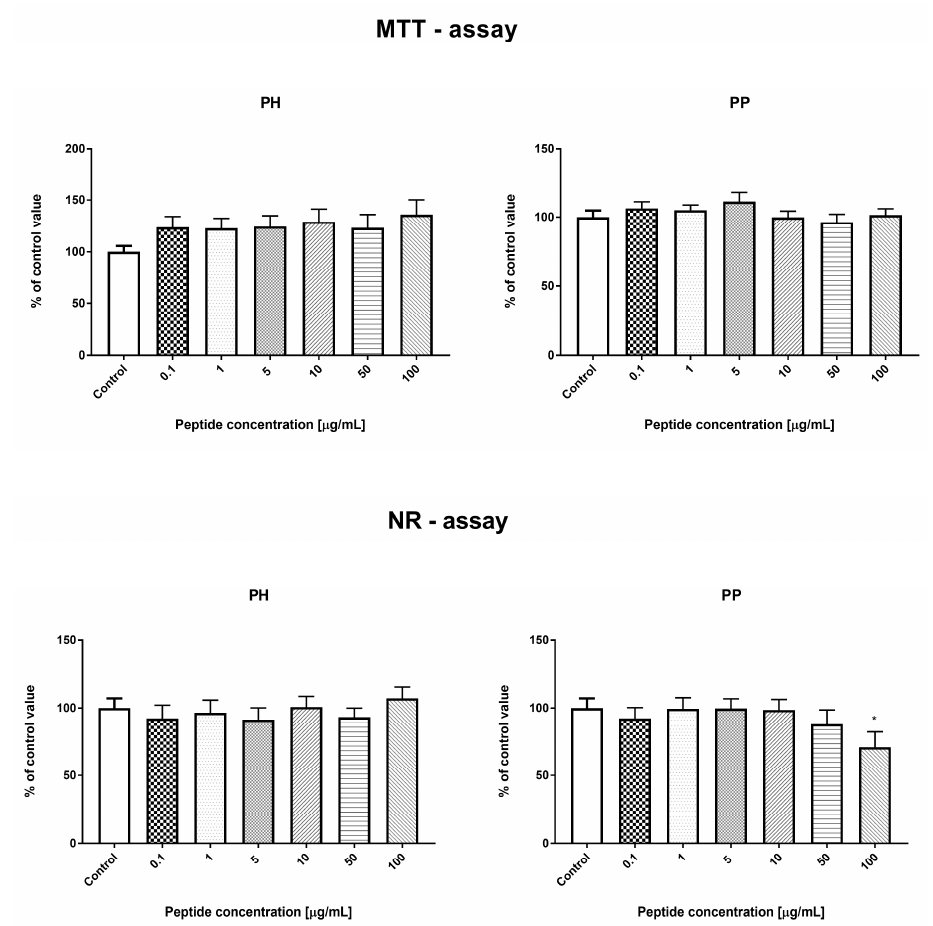
Figure 7. Result of MTT and NR tests for prolamin hydrolyzate (PH) and prolamin peptide fraction (PP). * p < 0.05.